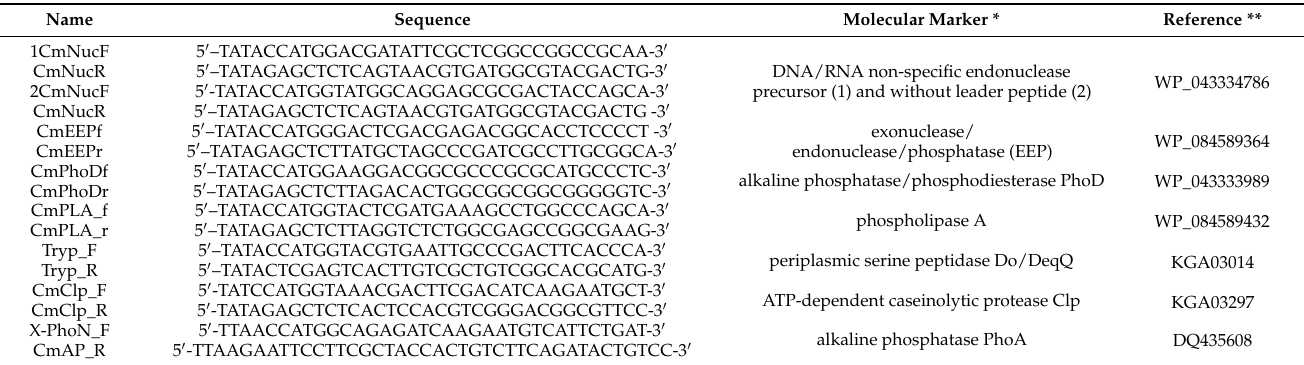
Table 2. Oligonucleotides for molecular differentiation of Cobetia